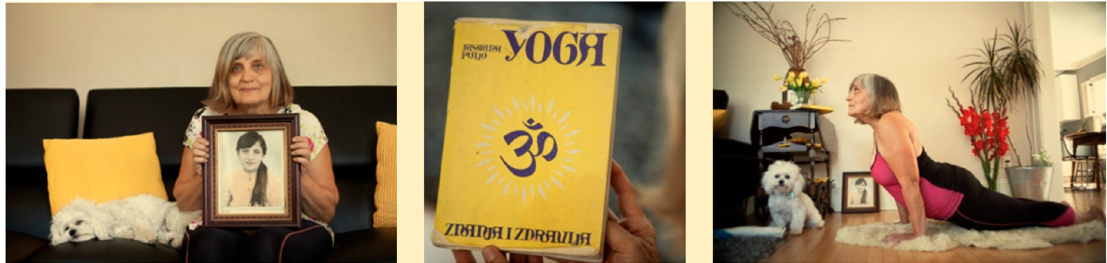
Figure 4. Jelka Jelka is holding a photo of herself when she was 11, the only object she still has from her childhood home. Jelka took up yoga with the help of an instructional book from her home country. Note: Jelka and the other subjects gave express written permission for their photos and quotes to be used in in this manner.